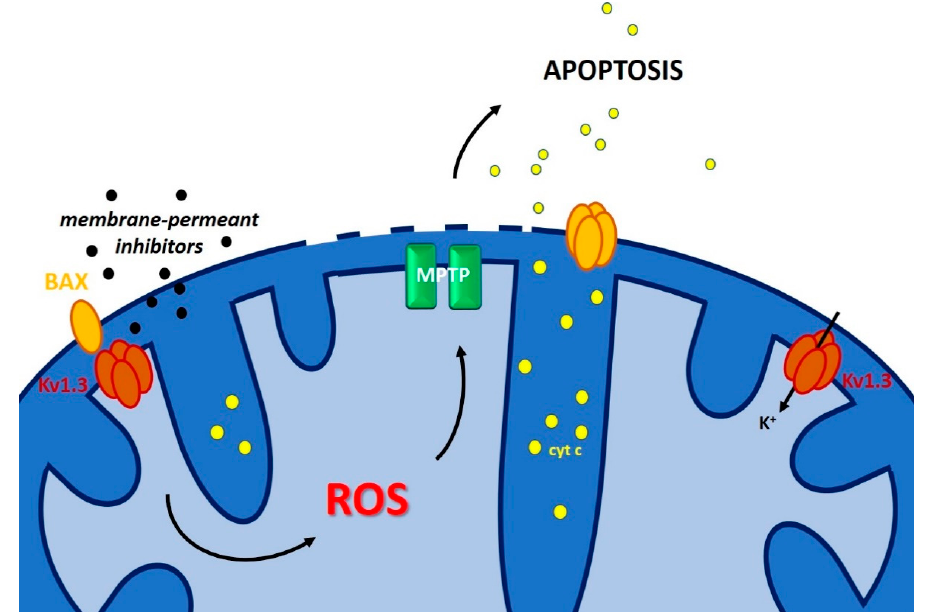
Figure 6. Direct pharmacological targeting of a mitochondrial potassium channel triggers cytochrome c release in cancer cells. Kv1.3 inhibition in the IMM by either BAX or membrane-permeant specific Kv1.3 inhibitors leads to IMM hyperpolarization that in turn triggers ROS release and